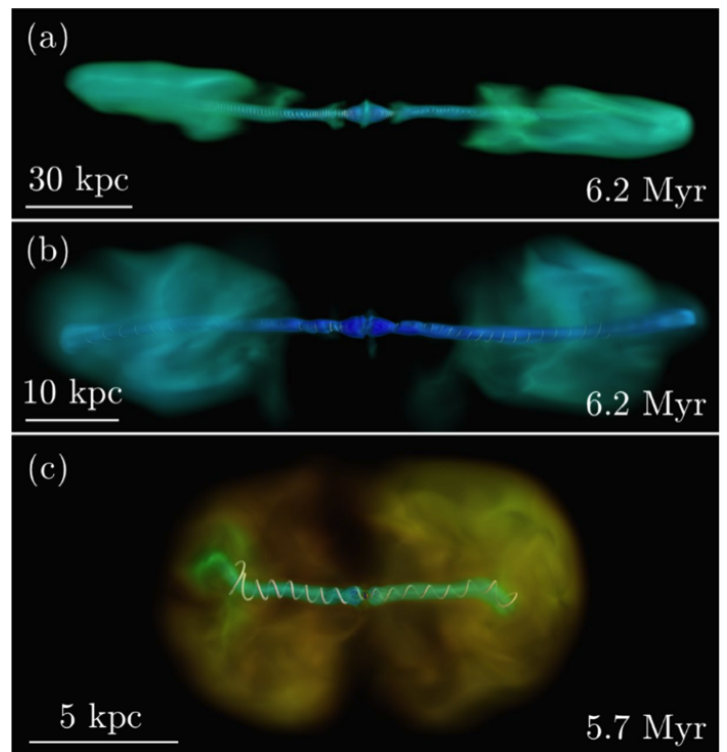
Figure 7. Volume rendering of simulated jets shows the logarithm of density (yellow-green shows high and blue shows low values). White lines show magnetic field lines. ( a ) High-power jets reach 100 kpc distances in 6 Myr. They are mostly straight apart from subtle, large-scale bends seen in FR II sources such as Cygnus A; after running into the ambient medium, the jets end up forming strong backflows, as characteristic of FR II jet sources. ( b ) Same high-power jets as those in panel ( a ) with a break in the ambient density power-law at 10 kpc. Their backflows are less well collimated. ( c ) Low-power jets reach a distance of 5 kpc in 3 Myr. Once there, they succumb to a global kink instability and remain stalled at this distance for 3 Myr. These jets inflate large cavities (shown in yellow) filled with a relativistically-hot plasma, as characteristic of FR I jet sources. (Figure 4 of